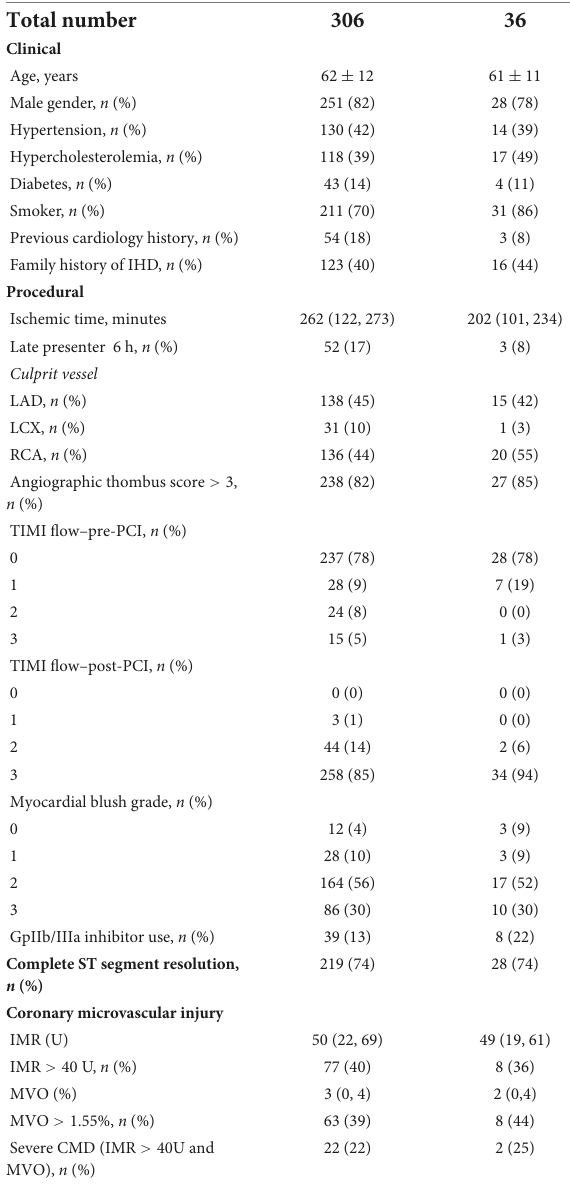
TABLE 1 Clinical, procedural, and coronary microvascular injury